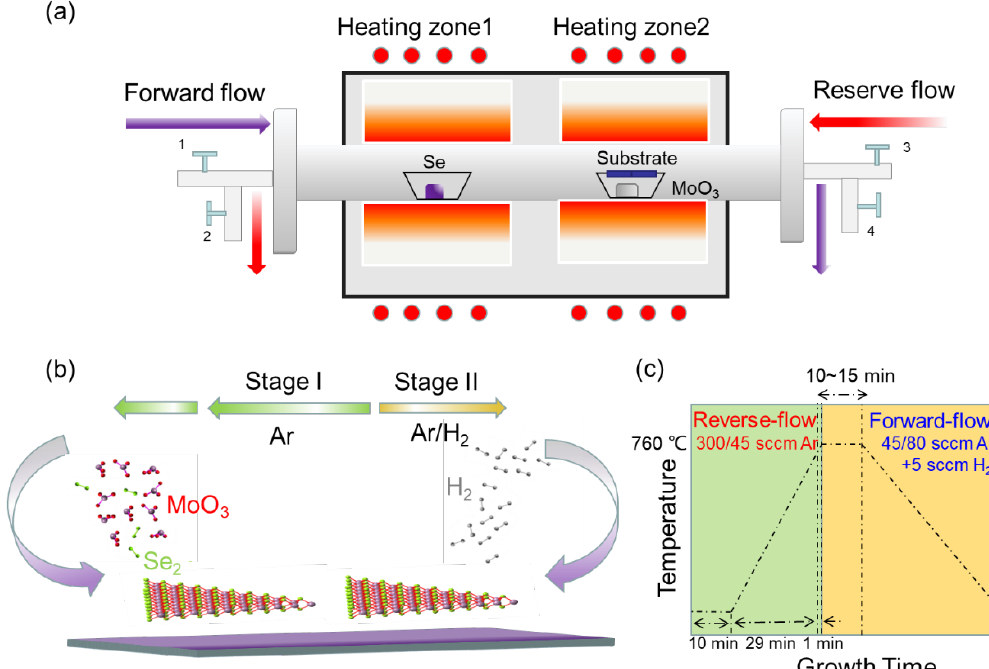
Figure 1. ( a , b ) Schematic illustration of two-temperature zone furnace reverse-flow chemical vapor deposition (CVD) setup and two growth stages. ( c ) The diagram of the growth time and temperature.